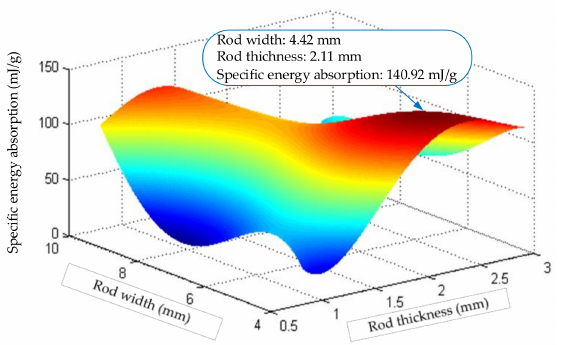
Figure 9. Response surface calculation diagram of Aluminum truss beam structure.